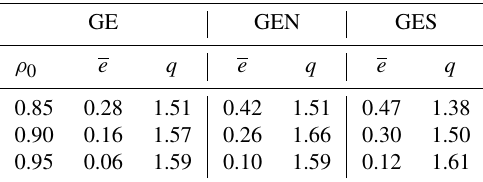
Table 10. A comparison of edge density and ratio q = e extr /e norm (extreme versus normal years) for the GE, GEN and GES regions and the correlation threshold ρ 0 = 0 . 85, 0.90 and 0.95 for heat- waves in